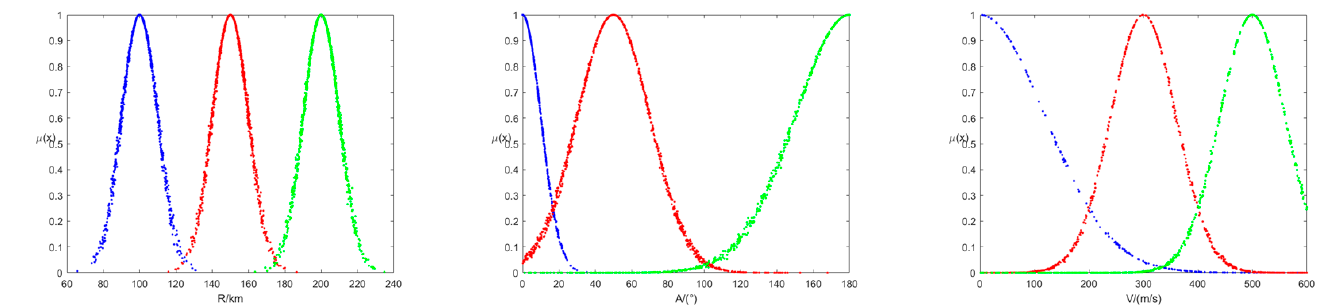
Figure 6. Gaussian cloud fuzzy membership of target attributes.